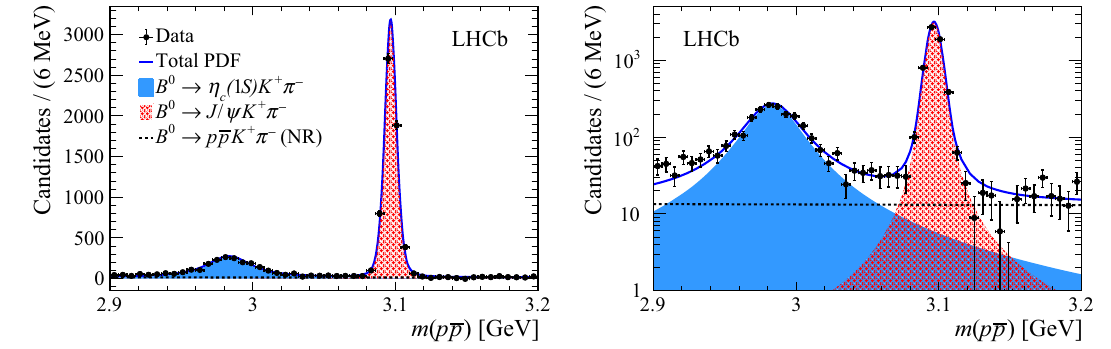
Fig. 3 Distribution of the pp invariant mass in (left) linear and (right) logarithmic vertical-axis scale for weighted B 0 → ppK + π − candi- dates obtained by using the sPlot technique. The solid blue curve is the